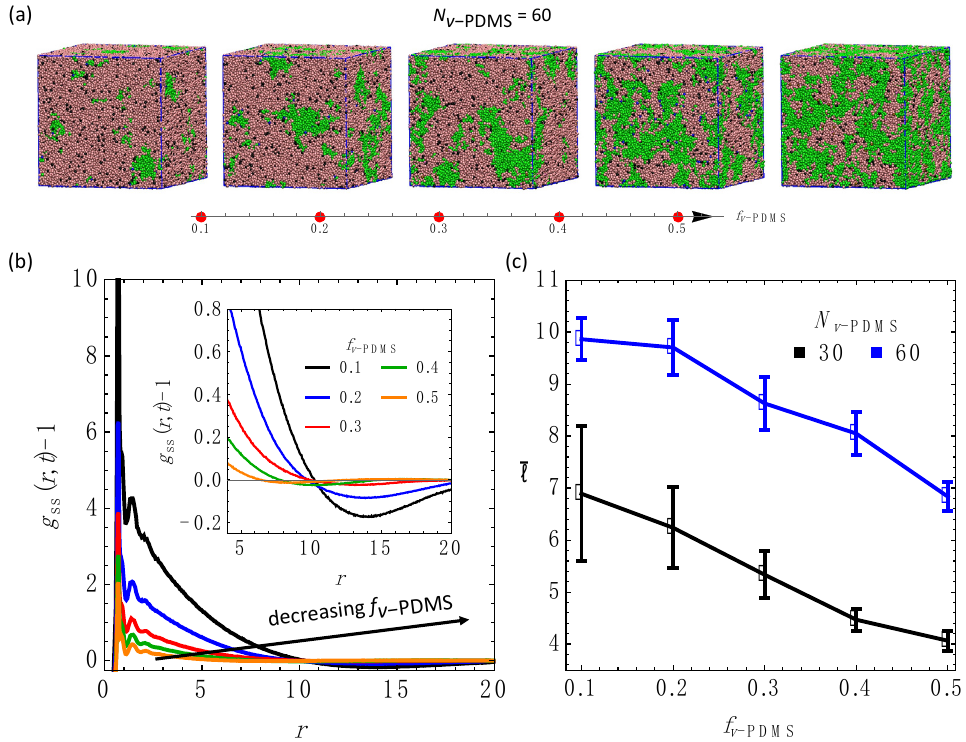
Figure 4. Effects of fraction of sacrificial component, f v − PDMS . ( a ) Snapshots of the blends with N v − PDMS = 60 and various f v − PDMS . The values of f v − PDMS from the left to the right are 0.1, 0.2, 0.3, 0.4, and 0.5. ( b ) The g ss ( r ) − 1 at various f v − PDMS as listed in the legend. ( c ) The average equilibrium characteristic length scale l as a function of f v − PDMS for N v − PDMS = 30 (in black) and N v − PDMS = 60 (in blue).